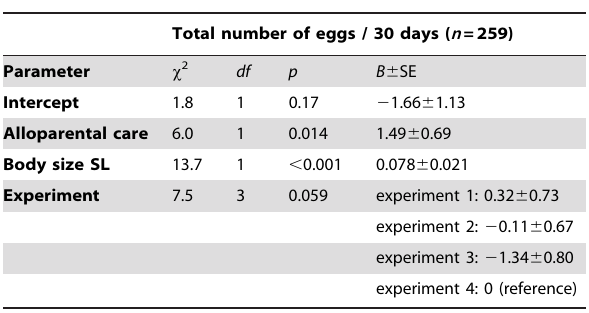
Table 3. Reproductive output of subordinate female group members depending on their investment in alloparental care (proportion of total female care), their body size (SL mm), corrected for differences between the experiments (1, 2, 3 or